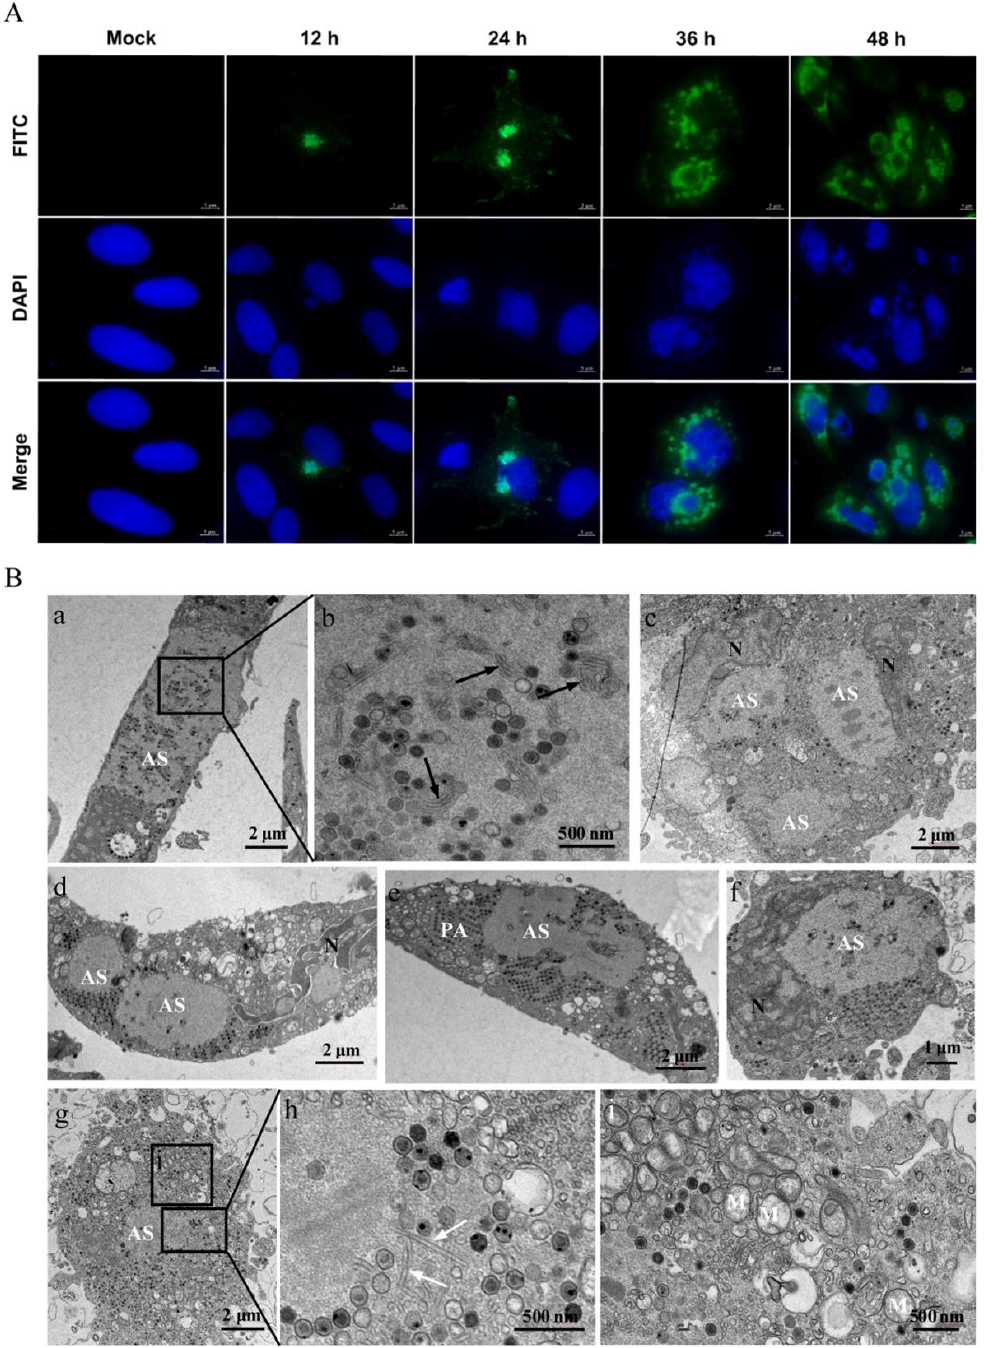
Figure 3. The characteristics of LMBV replication in MsF cells. ( A ) The intracellular localization of viral MCP in LMBV-infected MsF cells was detected using immunofluorescence assay. ( B ) The ultrastructural characteristics of LMBV assembly in MsF cells. ( a , g ): Numerous viral particles were observed in assembly sites (ASs) in LMBV-infected MsF cells. ( b , h ): Some amorphous or tubular structures were observed in assembly sites. Black and white arrows showed the amorphous and tubular structures, respectively. ( c – f ): The numerous hexagonal virus particles formed paracrystalline arrays (PAs) or scattered around the assembly sites in LMBV-infected MsF cells. ( i ): The vacuolized mitochondria were observed around the assembly sites. M: mitochondria; N: